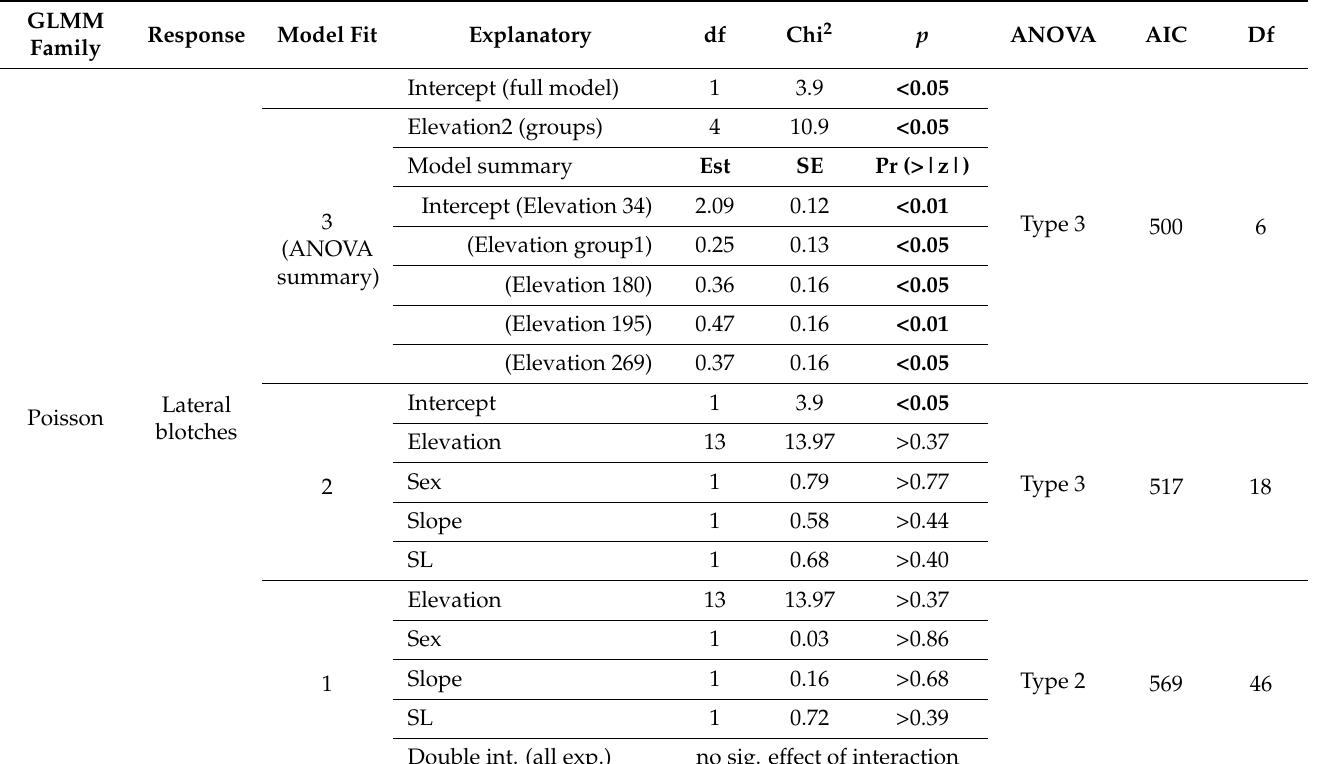
Table 3. Summary of GLMM (with mixed model effect of the localities) for lateral blotches (spots) of the 111 Sabanejewia spp. and explanatory